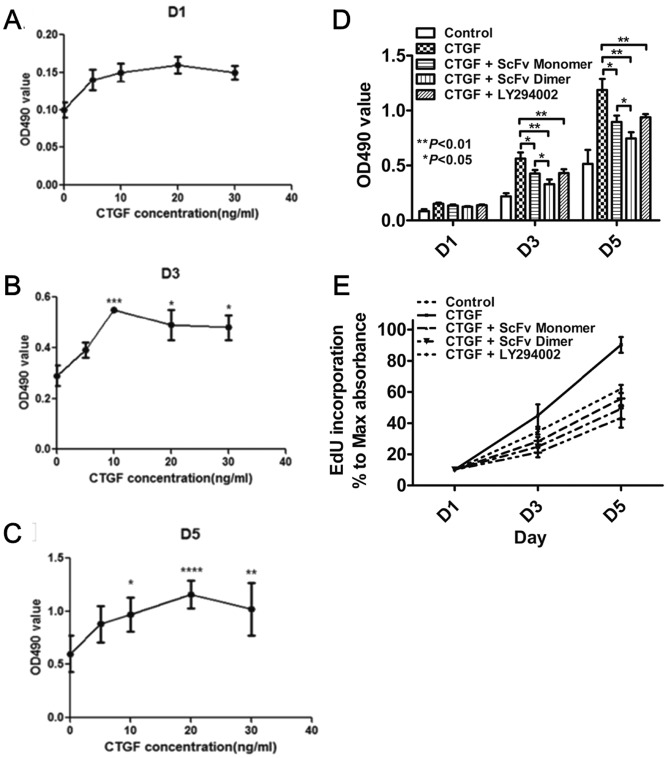
Human ASM cell proliferation after stimulated by CTGF.A. Results from the MTT assay after ASM cells were incubated in CTGF (0–30 ng/mL) for 1 day. B. Results from the MTT assay after ASM cells were incubated in CTGF (0–30 ng/mL) for 3 days. C. Results from the MTT assay after ASM cells were incubated in CTGF (0–30 ng/mL) for 5 days. D. The results from the MTT assay after ASM cells were incubated for 1–5 days in CTGF (10 ng/mL) with or without the scFv monomer, scFv dimer, or LY294002. E. The results from EdU incorporation assay after ASM cells were incubated for 1–5 days in CTGF (10 ng/mL) with or without the scFv monomer, scFv dimer, or LY294002. * p<0.05, ** p<0.01, *** p<0.005, **** p<0.001.